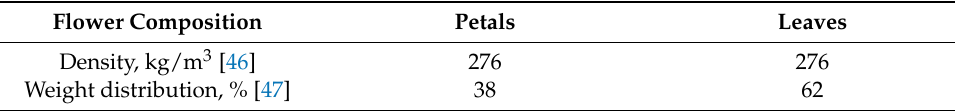
Table 4. Properties of flower waste.